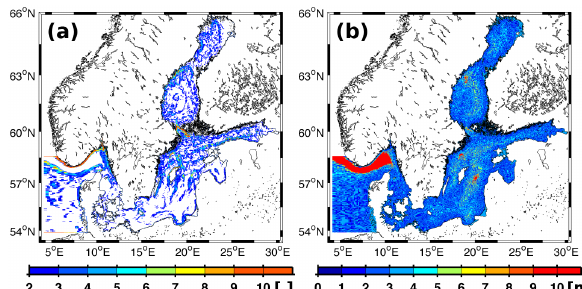
Figure 13. Topographic slope and thickness of lowermost wet grid box in MOMBA. Panel (a) shows the difference in the number of grid boxes representing neighbouring water columns. Of the respec- tive differences (up to four; calculated from all neighbours), panel (a) shows the maximum difference. Differences smaller than two grid boxes indicate “resolved” topographic slopes and are masked by white areas. Panel (b) shows the thickness of the lowermost wet grid box (note that we use partial cells). Fig. 14. Simulated deep saline inflow into the Bornholm Basin through Hamrare Strait along the transect indicated in the inlayed map. The color denotes salinity. The thick black dashed line is the surface mixed layer depth as calculated by the KPP scheme. The white (grey) contours denote upwards (downwards) velocities in mday − 1 . All properties are averaged over one hour.